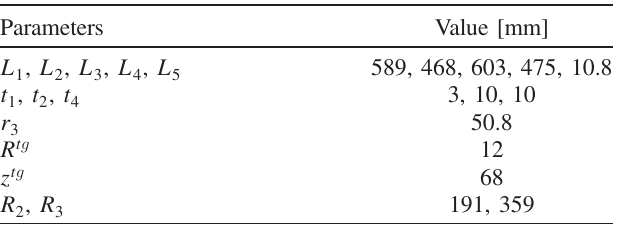
TABLE IV. Horn geometric parameters. z tg and R tg correspond to the target upstream face position and the target radius,